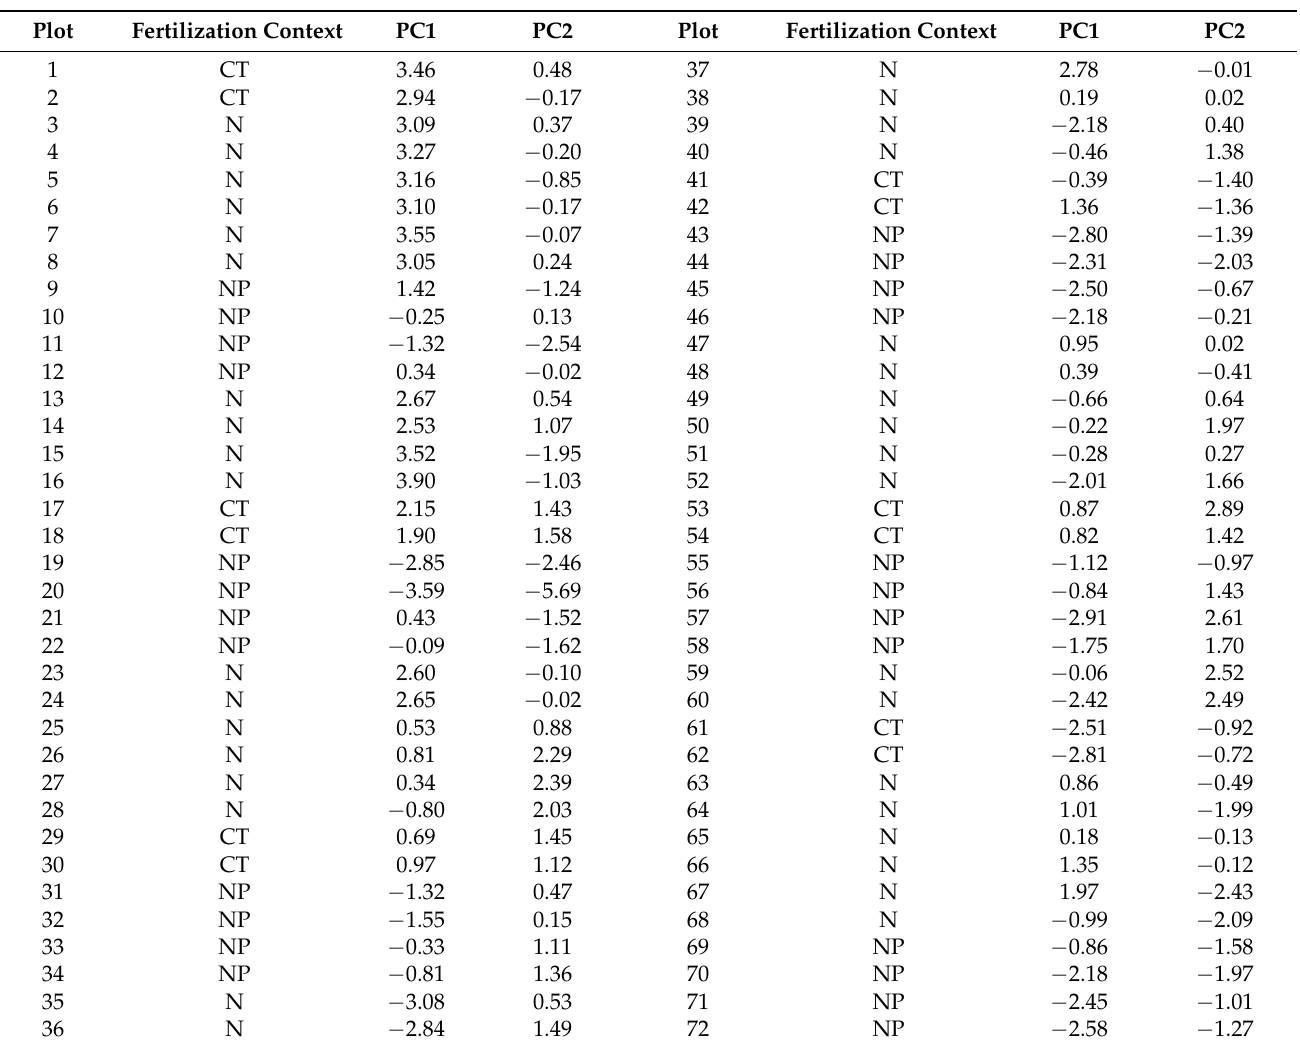
Table A2. Factor loading of each plot analyzed by principal component analysis (PCA). Only the first two axes are shown.